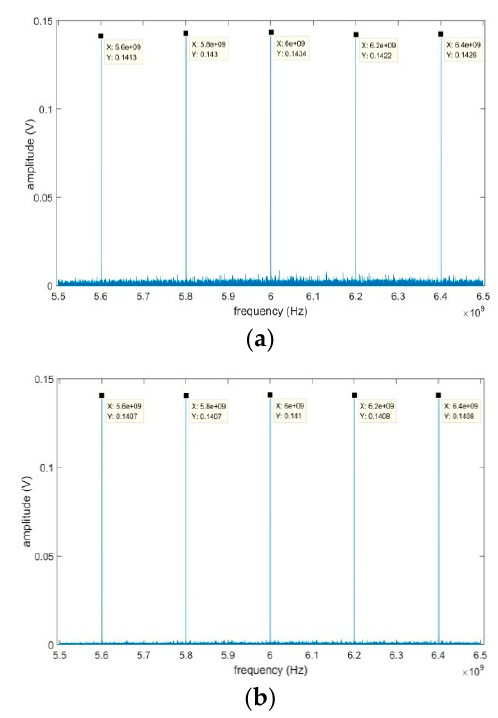
Figure 5. Output pulses calculated from five input frequencies. ( a ) is the result calculated by the classical time-domain pulse compression method. ( b ) is the result obtained by the novel LPSA